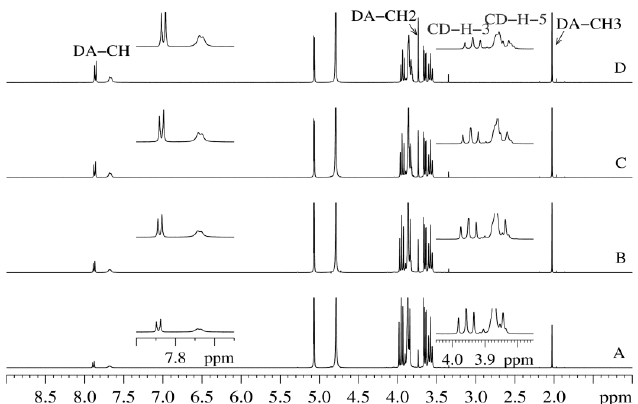
Figure 5. Full 1 H NMR spectra of DA: β CD mixtures, with mole fractions varied from 0 to 1: ( A ) 0.125 DA and 0.875 β CD; ( B ) 0.250 DA and 0.750 β CD; ( C ) 0.375 DA and 0.625 β CD; ( D ) 0.500 DA and 0.500 β CD. The inserts are showing upfield shifts for DA aromatic protons and H-3 and H-5 β CD protons, with increasing the DA mole fraction.